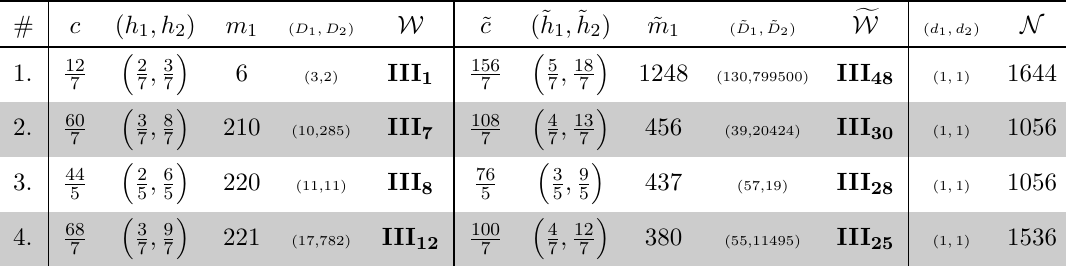
Table 11. IVOA-type pairings, c H = 24 with ( n 1 , n 2 ) = (1 , 3) . The integer N in the last column gives the total number of dimension-1 states in the meromorphic character j − 744 + N